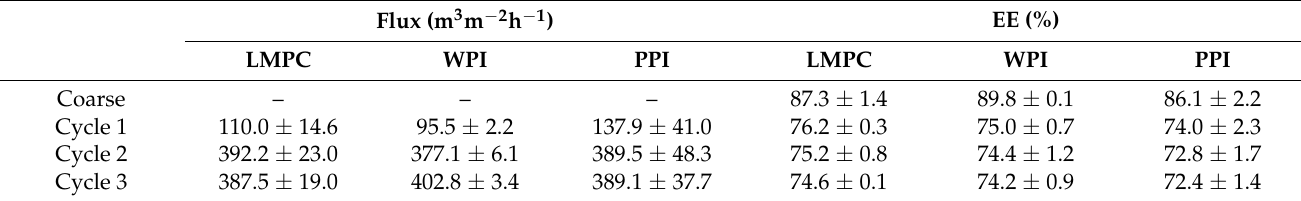
Table 2. Transmembrane fluxes and EE (encapsulation efficiencies) of double emulsions stabilized with 1% LMPC (lesser mealworm protein isolate), 1% WPI (whey protein isolate), and 1% PPI (pea protein isolate) at each emulsification cycle.